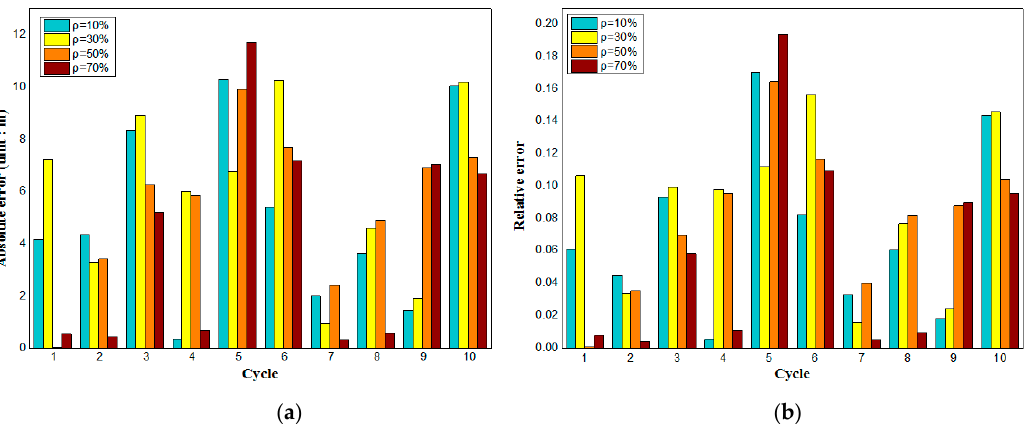
Figure 9. Error analysis of integrated queue length estimation model: absolute error (a) and relative error (b).